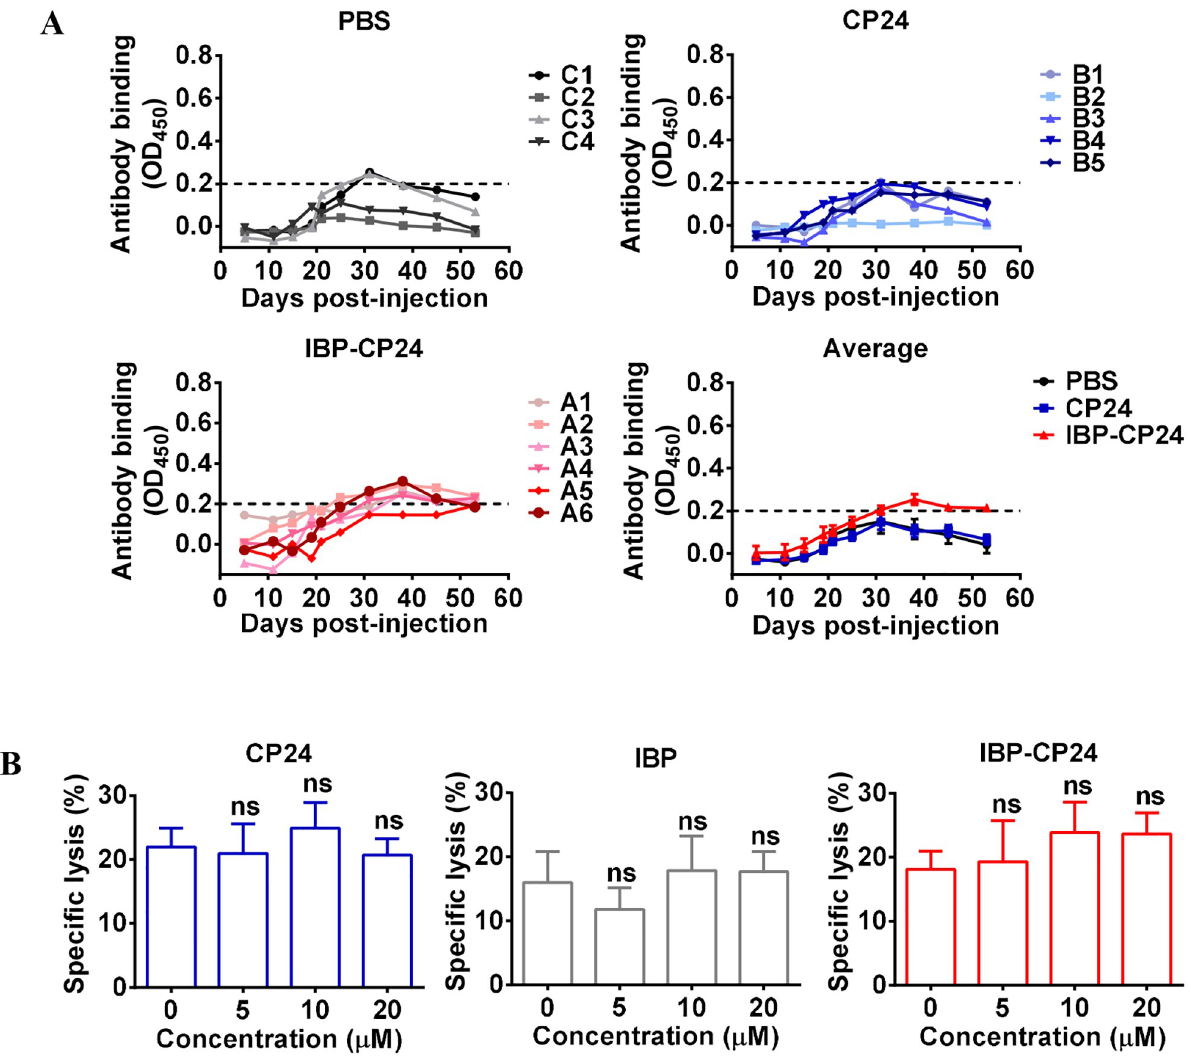
Fig 7. Detection of CP24 or IBP-CP24-specific antibody in the plasma of rhesus monkeys intravenously administered with CP24 or IBP-CP24 by indirect ELISA and effect of the peptides on antibody-mediated ADCC. (A) CP24 or IBP-CP24-specific antibody response in the CP24- or IBP-CP24-treated rhesus monkeys. The level of CP24 or IBP-CP24-specific IgG in the plasma of rhesus monkeys intravenously administered with PBS, CP24 or IBP-CP24 by indirect ELISA. The data were presented as mean ± SD. (B) Specific lysis of H9/HIV-1 IIIB -infected cells mediated by 10E8 and PBMC via antibody-dependent cell-mediated cytotoxicity (ADCC). Each sample was tested in triplicate and data were presented as mean ± SD. Unpaired, 2-tailed t test was performed. ns, no significance.